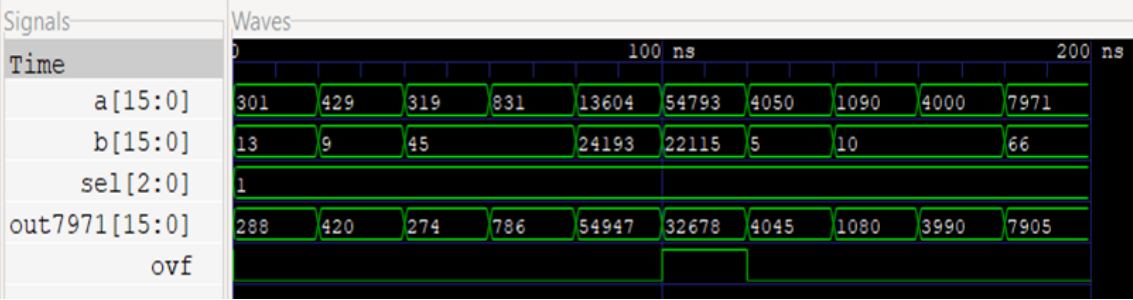
Figure 6. Circuit for the full subtractor generated through Verilog.